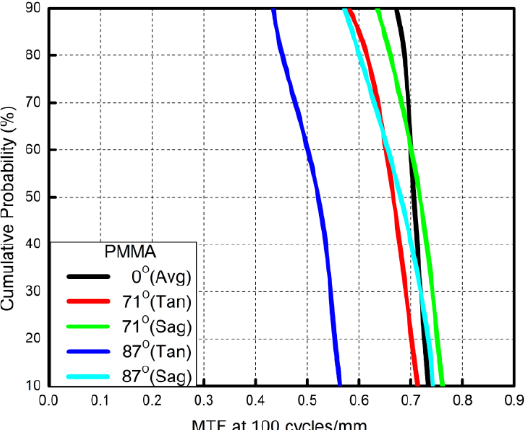
Figure 14. Cumulative probability vs. modulation transfer function (MTF) for fisheye lenses using